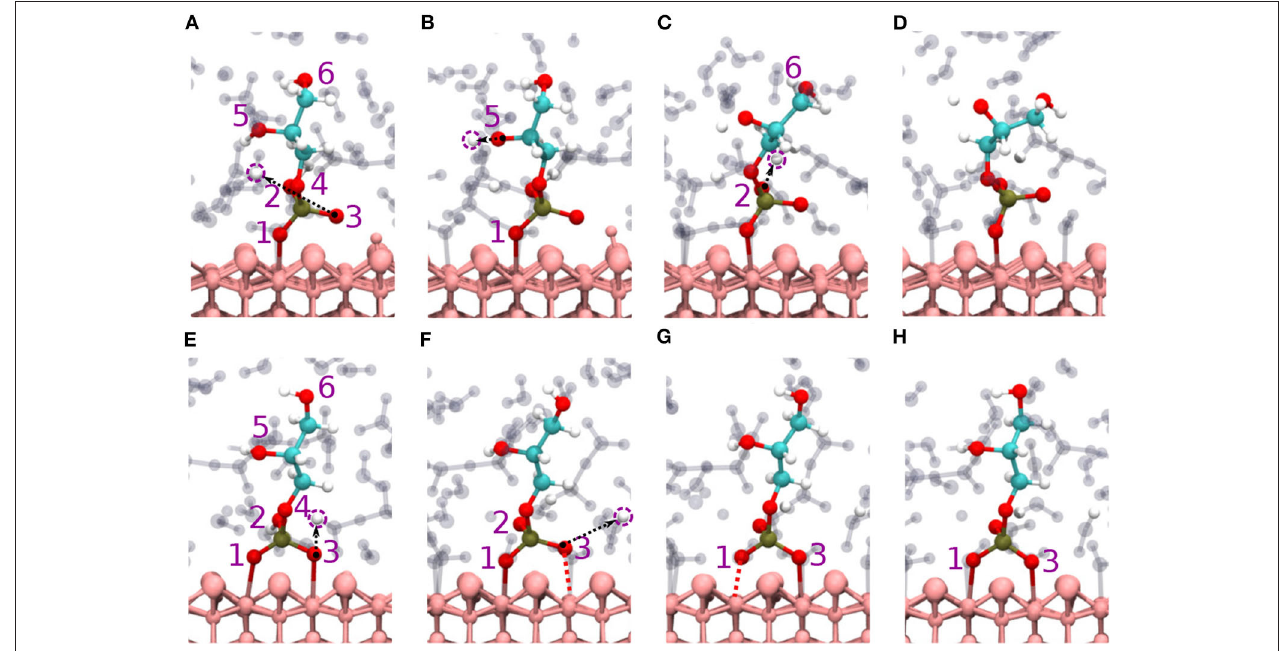
FIGURE 3 | Diaspore–GP–water snapshots displaying proton transfer events and GP dynamics along trajectories. Proton transfers observed during production trajectory of M motif from O3 to water (A) from O5 to water (B) , and from O2 to water (C) , GP M motif at 25 ps (D) . Proton transfer events in B (2Al+2O) motif from O3 to water (E) , from O2 to water and momentary dissociation of Al1-O1 bond (F) , momentary dissociation of Al2-O3 bond (G) , GP B motif at 25 ps (H) .